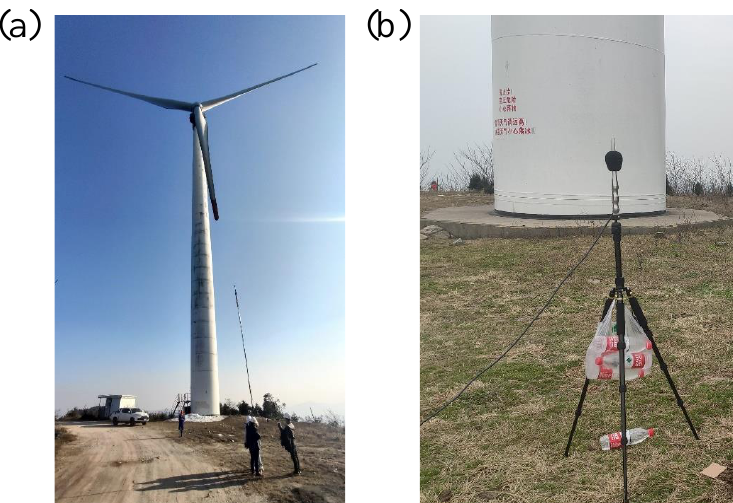
Figure 7. Data acquisition at wind farm: ( a ) location C; ( b ) location D.